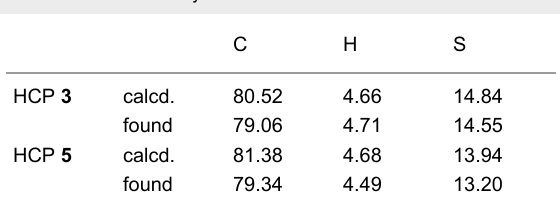
Table 1: Elemental analyses of HCPs 3 and 5 .